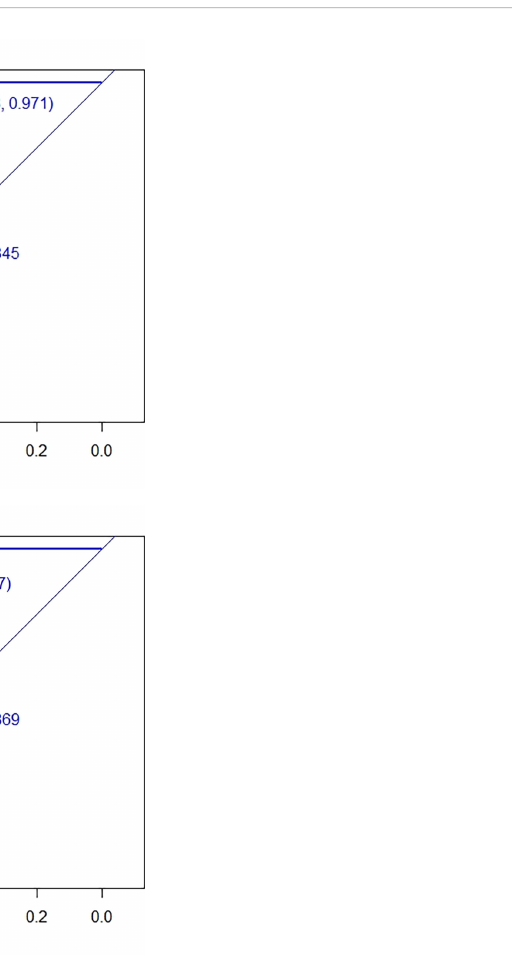
FIGURE 2 ROC curves for validating the discrimination power of the nomogram. (A) Development group. (B) Validation group.